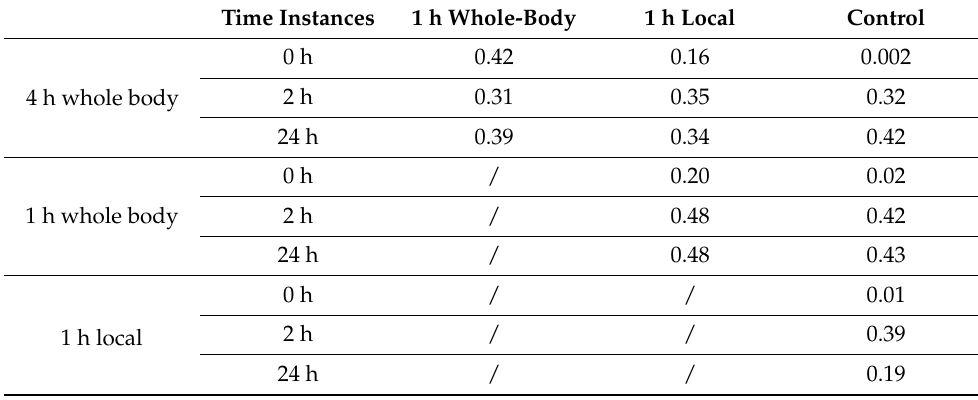
Table 2. Calculations of the p -value of the two specific groups using Student’s t -test for the normalized blood perfusion rates in the mouse body. It should be noted that the comparison of the two groups was conducted at the same time instance, i.e., 0 h, 2 h, or 24 h post-heating. Time Instances 1 h Whole-Body 1 h Local Control 0 h 0.42 0.16 0.002 2 h 0.31 0.35 0.32 4 h whole body 24 h 0.39 0.34 0.42 0 h / 0.20 0.02 0.48 1 h whole body